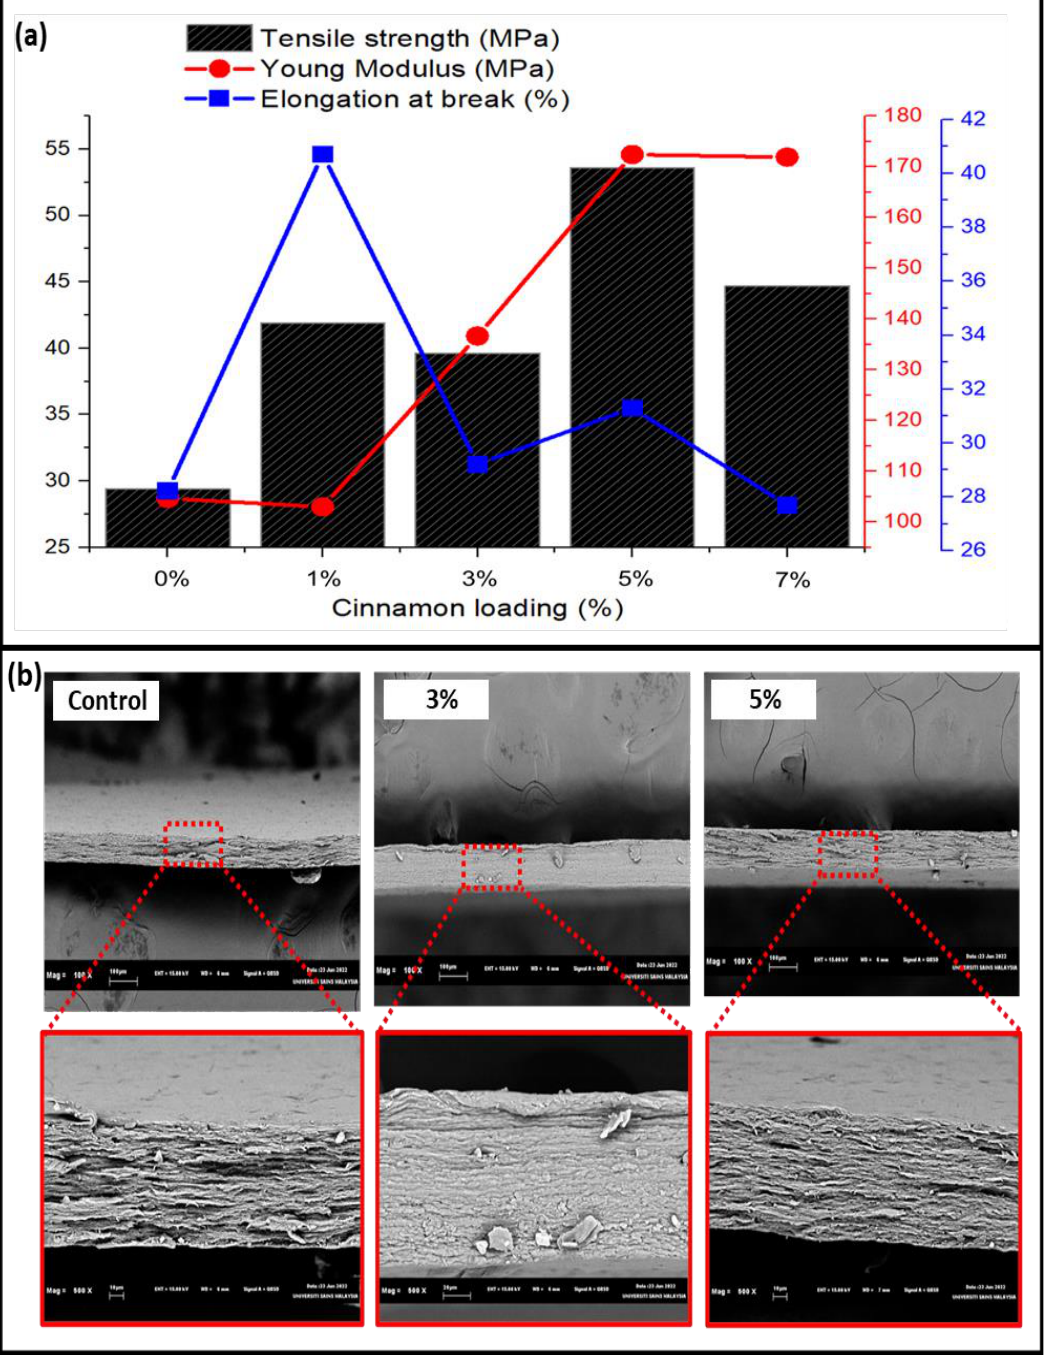
Figure 5. ( a ) Tensile properties of the fabricated seaweed-based cinnamon film, including tensile strength, Young’s modulus, and elongation at break. ( b ) Fracture surface morphology of the seaweed-based cinnamon particle film.